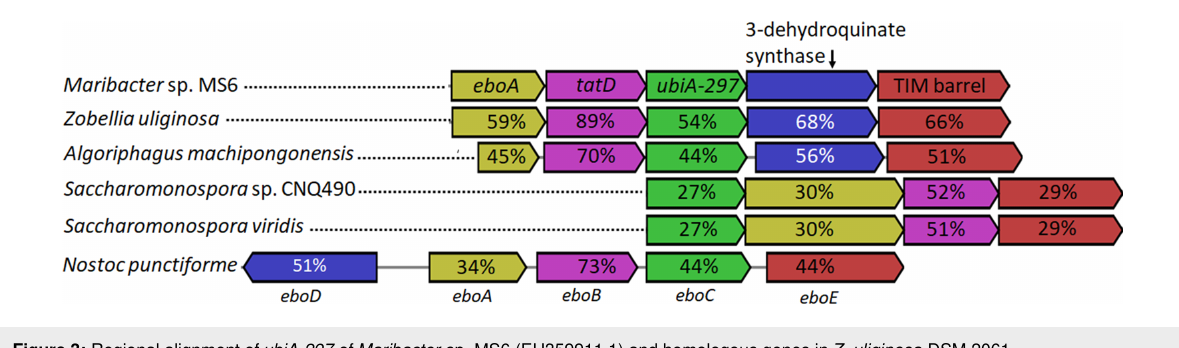
Figure 3: Regional alignment of ubiA-297 of Maribacter sp. MS6 (EU359911.1) and homologous genes in Z. uliginosa DSM 2061 (NZ_FTOB01000006), A. machipongonensis PR1 (NZ_CM001023), Saccharomonospora sp. CNQ490 (NZ_AZUM01000003), S. viridis DSM 43017 (NC_013159), and Nostoc punctiforme PCC 73102 (NC_010628). Percentage identities of homologous genes are given in the same colored arrow boxes ( Maribacter sp. MS6 was set as